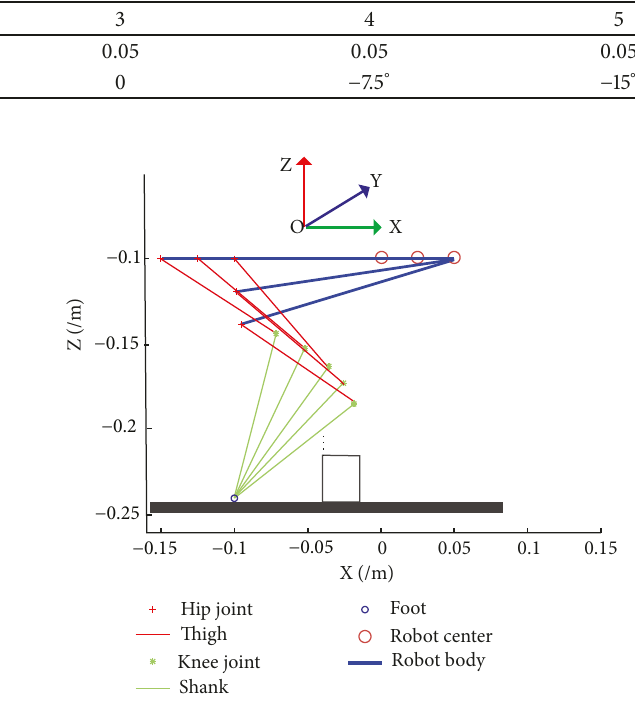
Figure 5: Foot Trajectory.